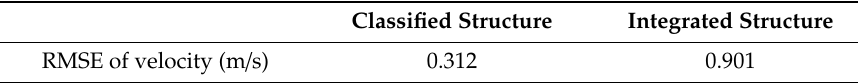
Table 6. Comparison of classified and integrated structures.